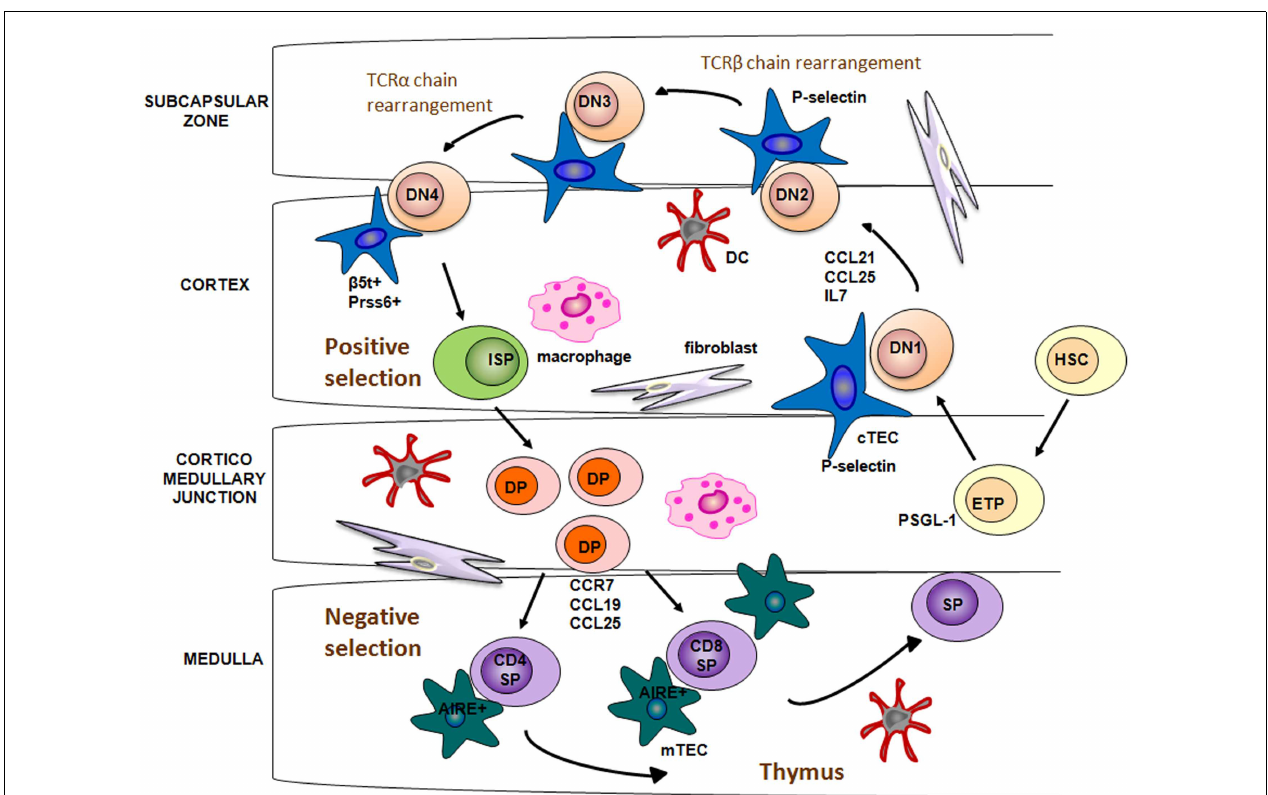
ligands are positively selected.This process is regulated by Pssr6 and b5t, which are expressed in cTECs. Developing thymocytes are relocated from cortex to the medulla by chemotactic attraction between CCR7 and the ligands CCL19/CCL21, expressed on the mTECs. Into medulla, self-reactive thymocytes are deleted through the negative selection, a process mediated by dendritic cells and Aire-expressing